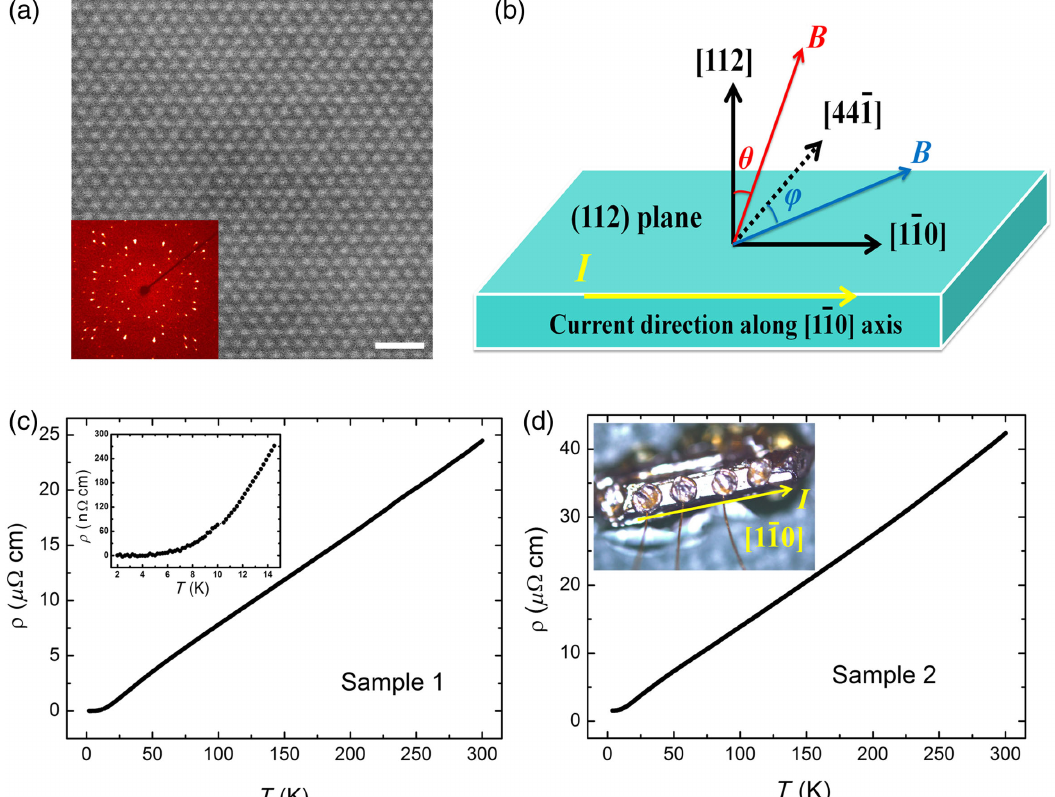
FIG. 1. Sample structure of Cd 3 As 2 single crystal. (a) HAADF STEM image of Cd 3 As 2 single crystal. Scale bar represents 1 nm. Inset shows the crystal XRD image. (b) Schematic structure for the angular-dependent magnetotransport measurements in Cd 3 As 2 system. 1¯ 1 0 Þ Sample is rotated in ð plane and (112) plane, characterized by the angle θ and φ , respectively. The sample size is not to scale. (c) Resistivity of sample 1 as a function of temperature. The inset shows the resistivity falling to quite low value about 11 . 6 n Ω cm at 6 K and then reaching zero resistivity within instrumental resolution. (d) ρ ( T ) behavior of sample 2. The inset shows an optical image of the measured Cd 3 As 2 sample. Standard four-probe method is used to measure the transport